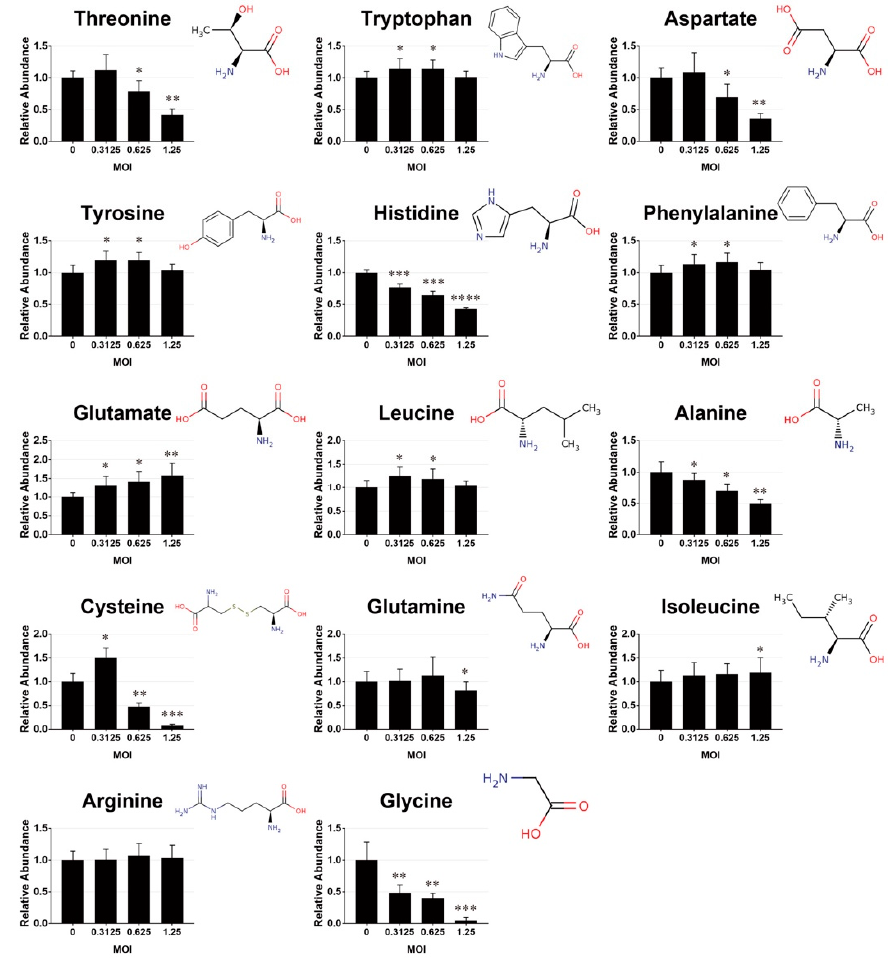
Figure 2. EV71 infection is associated with variations in amino acid pools. Vero cells were infected and extracted for metabolomic analysis, as described in Figure 1. Features corresponding to specific amino acids were extracted. The levels of metabolites are expressed relative to those of mock-infected cells. Data are mean ± SD (n = 9). * p < 0.05, ** p < 0.01, *** p < 0.005, significant difference from mock-infected